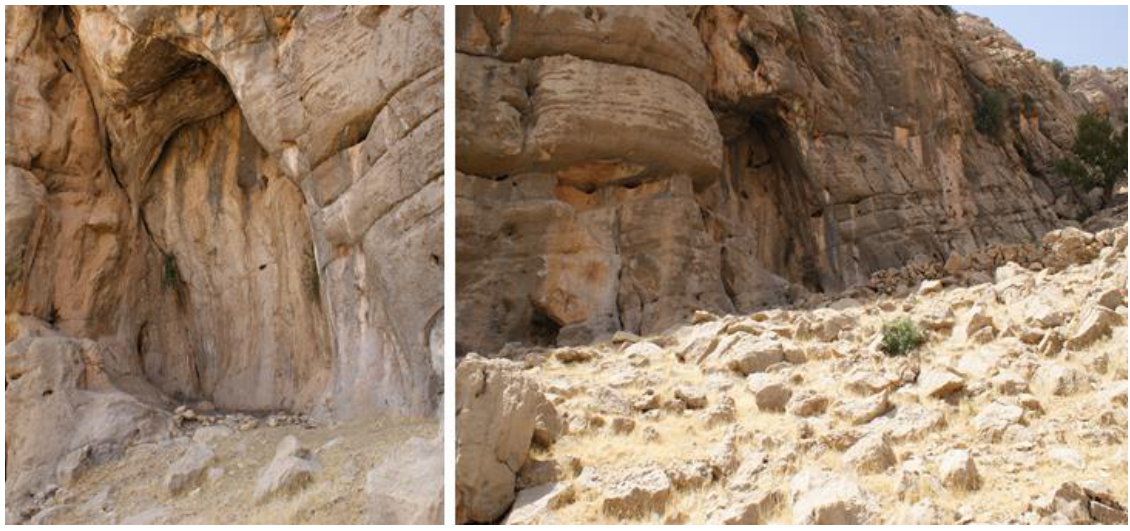
Figure 6. View of Eshkaft-e-Gorgali.